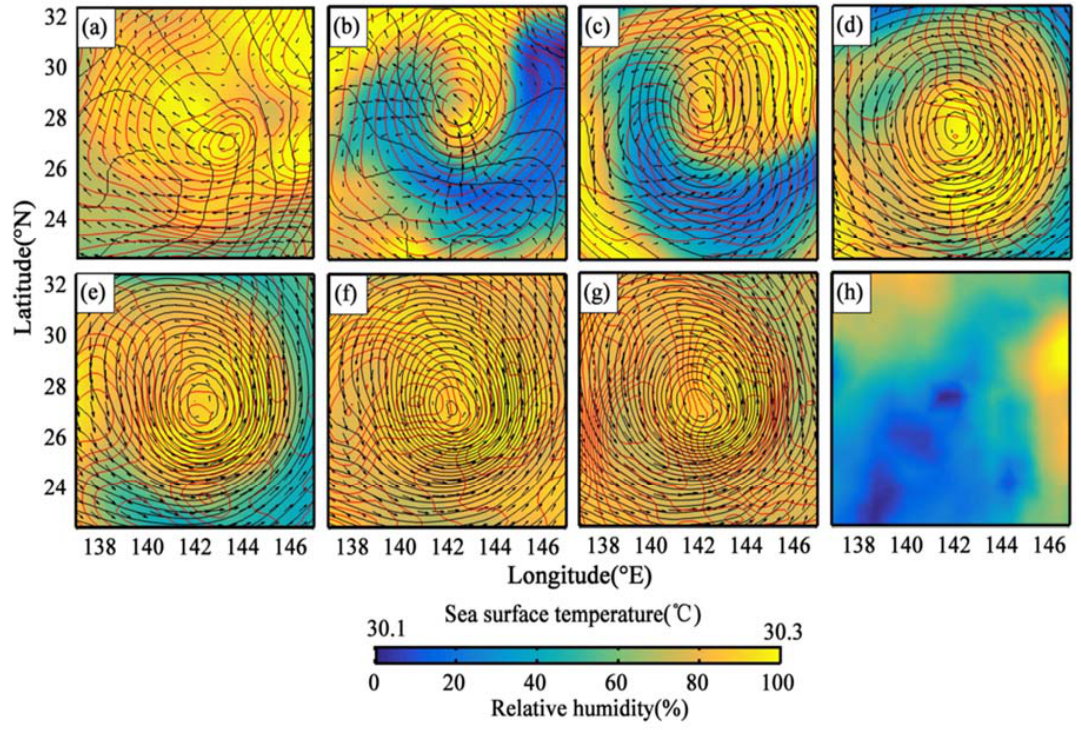
Figure 3. Images of atmospheric and oceanic variables at each level: ( a ) 100 hPa, ( b ) 200 hPa, ( c ) 300 hPa, ( d ) 500 hPa, ( e ) 700 hPa, ( f ) 850 hPa, ( g ) 1000 hPa, and ( h ) sea surface. In each image, vector arrows represent wind information (length for magnitude (m / s), arrowhead for direction), red contours represent temperature ( ◦ C), black contours represent geopotential height (gpm), and colors represent relative humidity (%) in ( a – g ) and sea surface temperature (SST) ( ◦ C) in ( h ). The time corresponding to the depicted TC state is 06:00 a.m. on 31 August 2017.